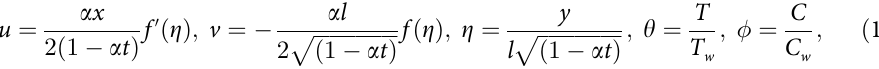
y ffiffiffiffiffiffiffiffiffiffiffiffiffiffiffiffi p ; y ¼ ð 1 (cid:0) a t Þ l